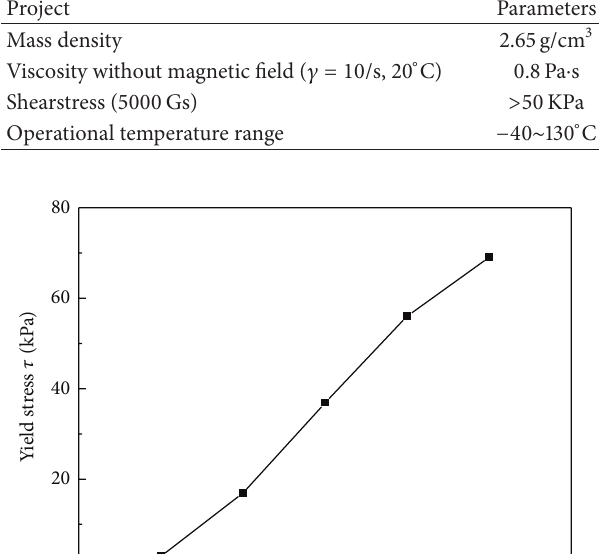
= 865.3901 kPa/T 2 , and 2